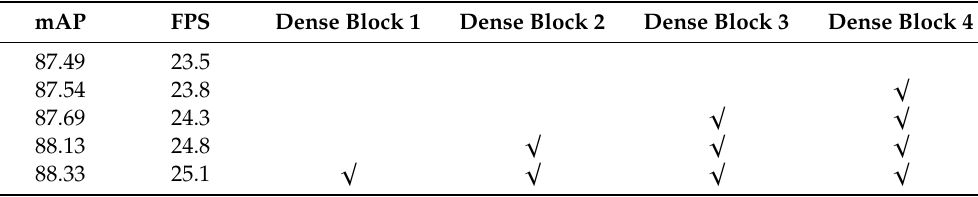
Table 14. The influence of ‘Dense block’ on remote sensing target detection. mAP